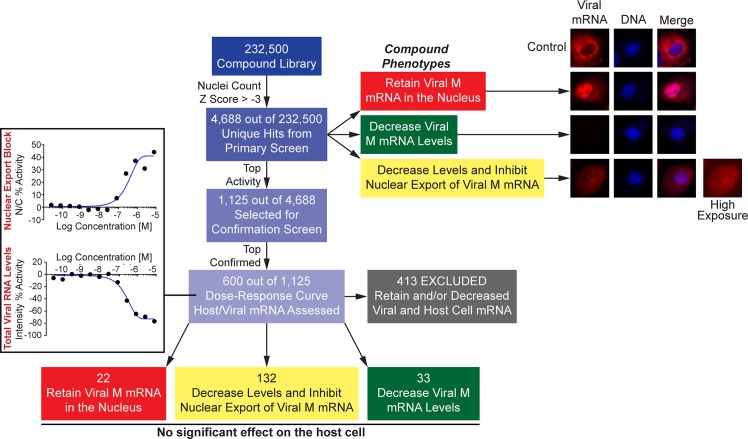
Schematic representation of identification and selection of top hits that inhibit viral M mRNA nuclear export and/or expression.Out of the 232,500 compounds tested in the primary screen, we selected compounds with Z-scores ≥ 3 for the N/C ratio and compounds that decreased viral mRNA levels with Z-scores ≤ -3. Compounds that reduced nuclear count significantly (Z-score < -3) were considered cytotoxic and were eliminated from further consideration. Of those remaining, the 1,125 compounds with the highest Z-scores were chosen for confirmation studies. The top 600 compounds from single-dose confirmation studies were further evaluated in a 12-point dose response study to assess the potency (AC50 –concentration at 50% activity). Examples of dose-response curves showing phenotypes of hits that induced viral M mRNA nuclear export block (increased N/C) and decrease in viral M mRNA levels (decreased intensity) are depicted. During this step, bulk cellular poly(A) RNA localization and intensity were also assessed by smRNA-FISH to determine the effect of these compounds on host cell mRNA (intensity and N/C ratio). Compounds that inhibited viral mRNA nuclear export and/or decreased viral mRNA levels but had no significant effect on the host cell poly(A) RNA were then selected for additional assays.